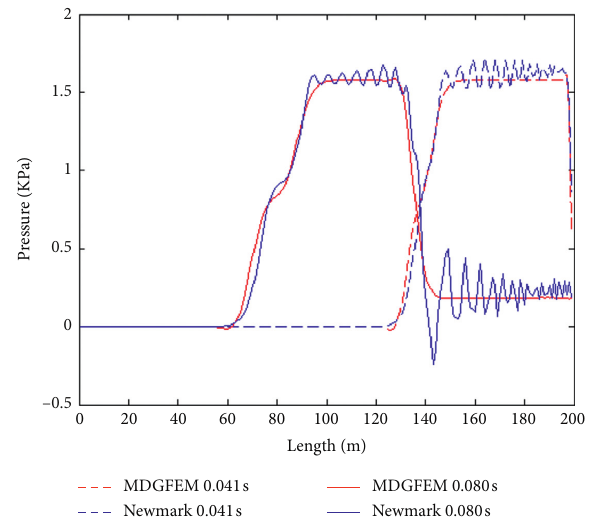
Figure 5: Pressure profiles of different methods at t � 0.041s and t � 0.08 s.